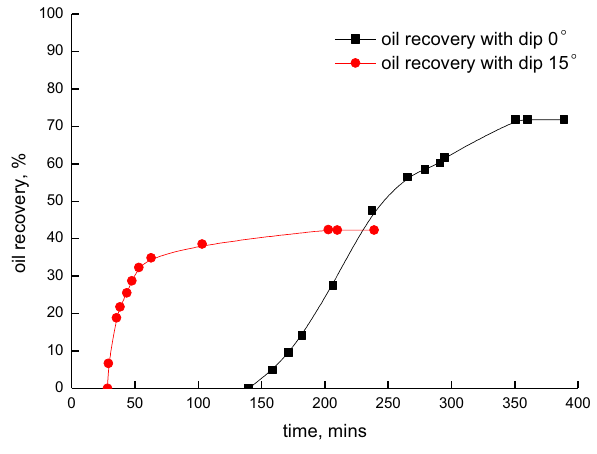
Fig. 12 The oil recovery comparison of ISC in 40-m-thick reservoir of different structural dip (0° and